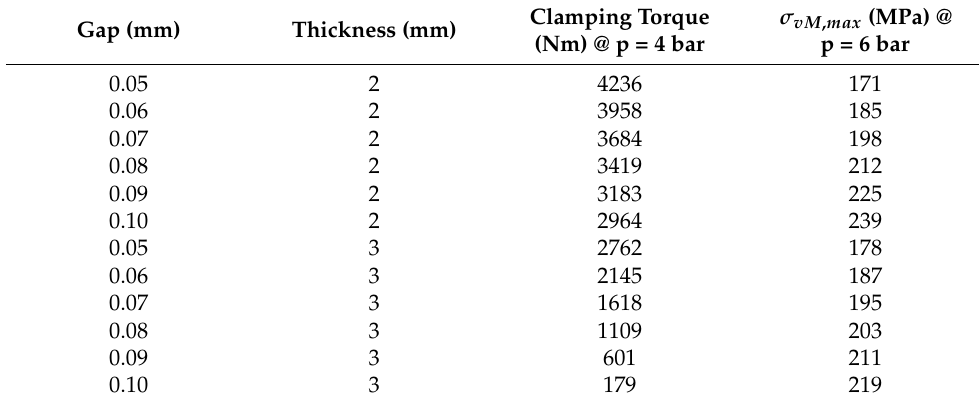
Table 4. Clamping torque and thickness for fillet radii of 2 mm.